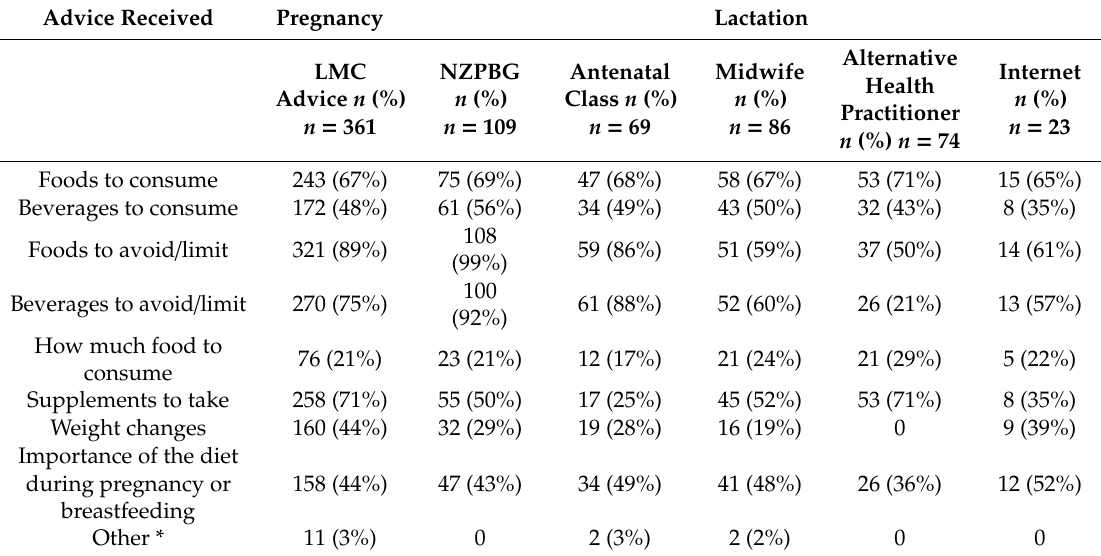
Table 8. Advice received from information sources in pregnancy and lactation.